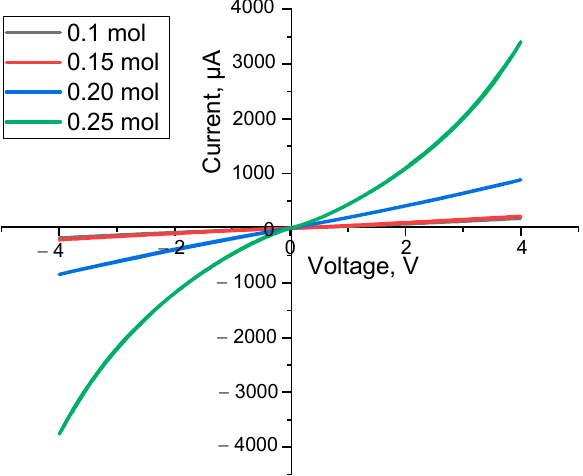
Figure 6. Graphs of cyclic current–voltage characteristics of synthesized ceramics depending on the lanthanum concentration.